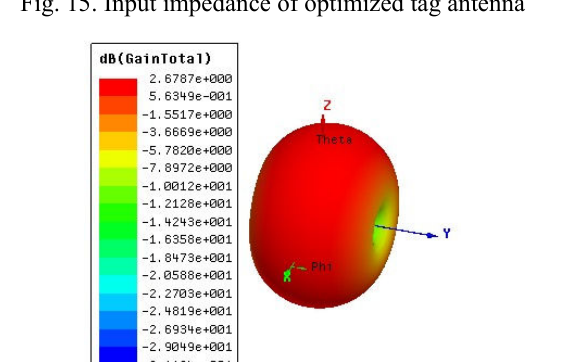
Fig. 15. Input impedance of optimized tag antenna